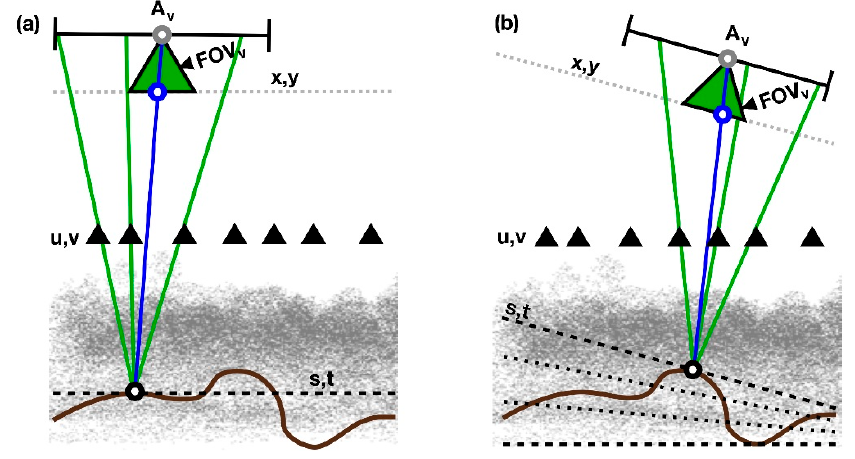
Figure 2. For visualization, we interactively define a virtual camera (green triangle) by its pose, size of its aperture, field of view, and its focal plane. Novel images are rendered by ray integration (Equation (1)) for points s , t at the focal plane (black circle) that are determined by the intersection of rays (blue) through the camera’s projection center (grey circle) and pixels at x , y in the camera’s image plane (blue circle) within its field of view FOV v . Only the rays (green) through u , v at the synthetic aperture plane that pass through the virtual camera’s aperture A v , are integrated. While ( a ) illustrates the visualization for a single focal plane, ( b ) shows the focal slicing being applied to increase the depth of field computationally.